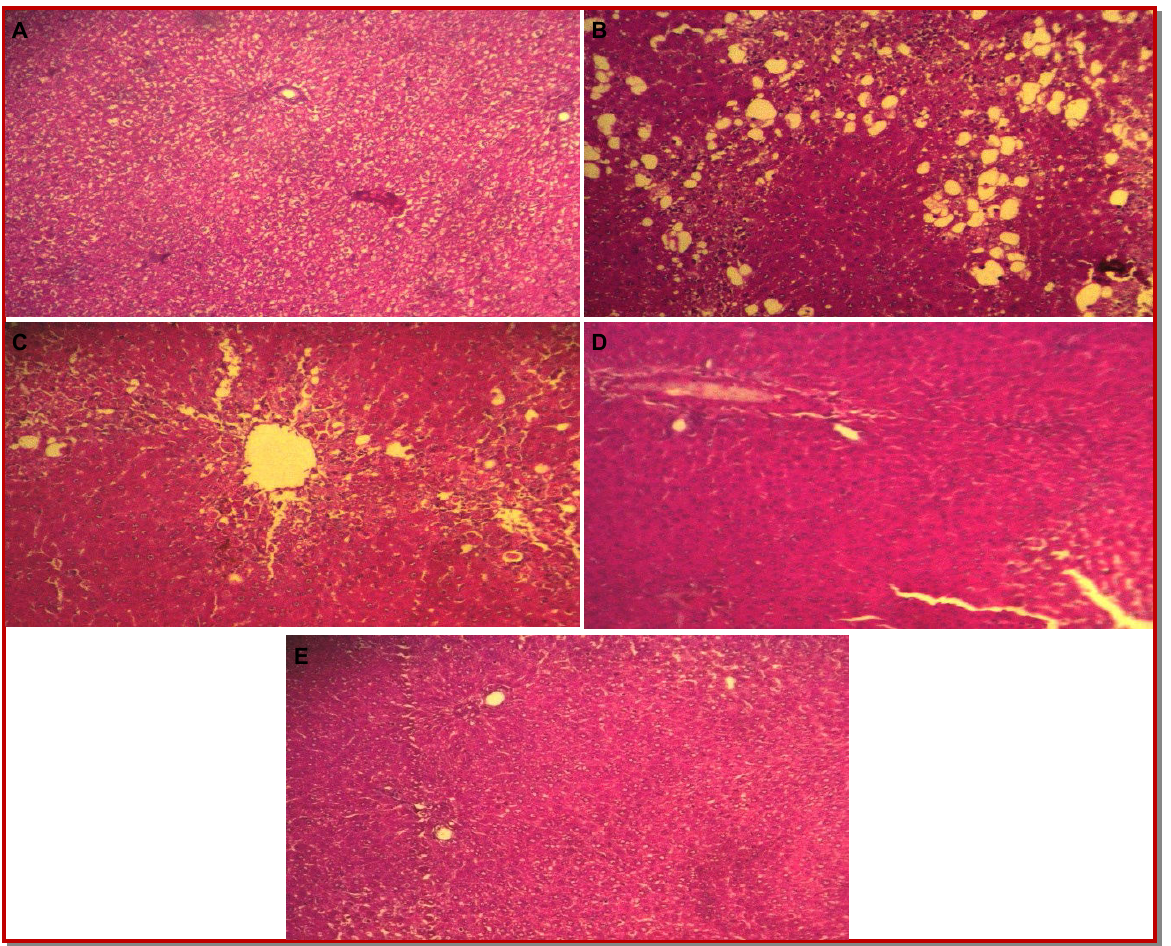
Figure 1: Photomicrographs of liver sections of rat stained with hemotoxylin and eosin (x100). A) normal rats (Group I) showing normal architecture; B) carbon tetrachloride-treated rats (Group II) showing steatosis and necrosis; C) carbon tetrachloride plus extract (200 mg/kg)-treated rats (Group III) showing moderate restoration of liver architecture; D) carbon tetrachloride plus ex- tract (400 mg/kg)-treated rats (Group IV) showing almost normal of liver architecture; E) silymarin-treated rats (Group V) show- ing significant restoration of liver architecture comparable with normal